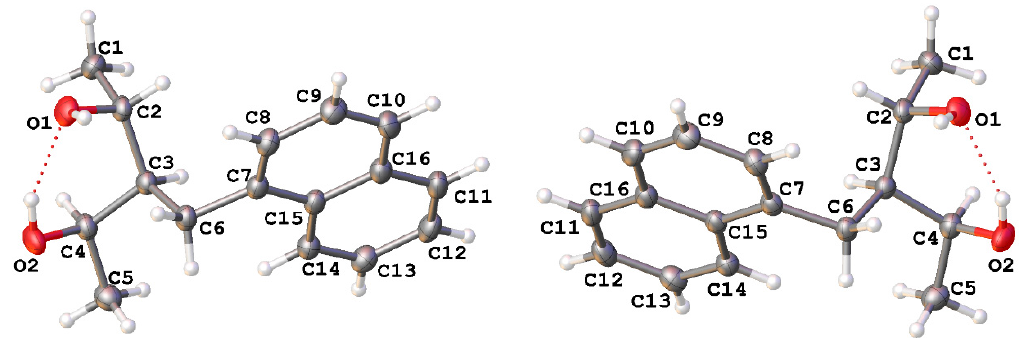
Figure 1. Absolute configuration of compounds 4a and 4b .